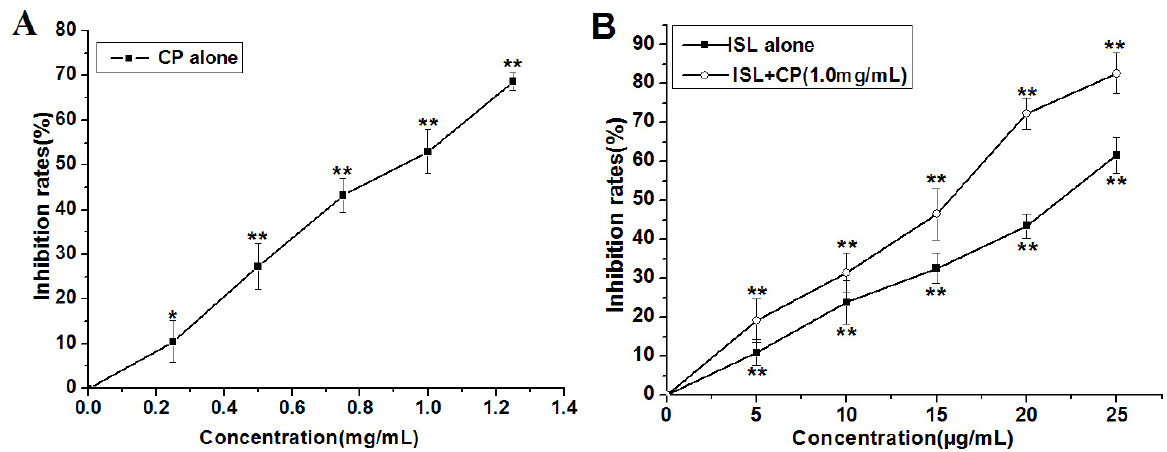
Figure 2. Effects of ISL, CP alone or their combination (ISL + CP) on U14 cells proliferation. ( A ) The inhibition rate on cell proliferation after 48 h treatment with CP (0, 0.25, 0.5, 0.75, 1.0, 1.25 mg/mL) alone; ( B ) The inhibition rate on cell proliferation after 48 h treatment with ISL (5, 10, 15, 20 and 25 μ g/mL) alone or ISL (5, 10, 15, 20 and 25 μ g/mL) co-treatment with CP (1.0 mg/mL). Data are presented as mean ± S.D. from three independent experiments. ** p < 0.01; * p < 0.05 versus control